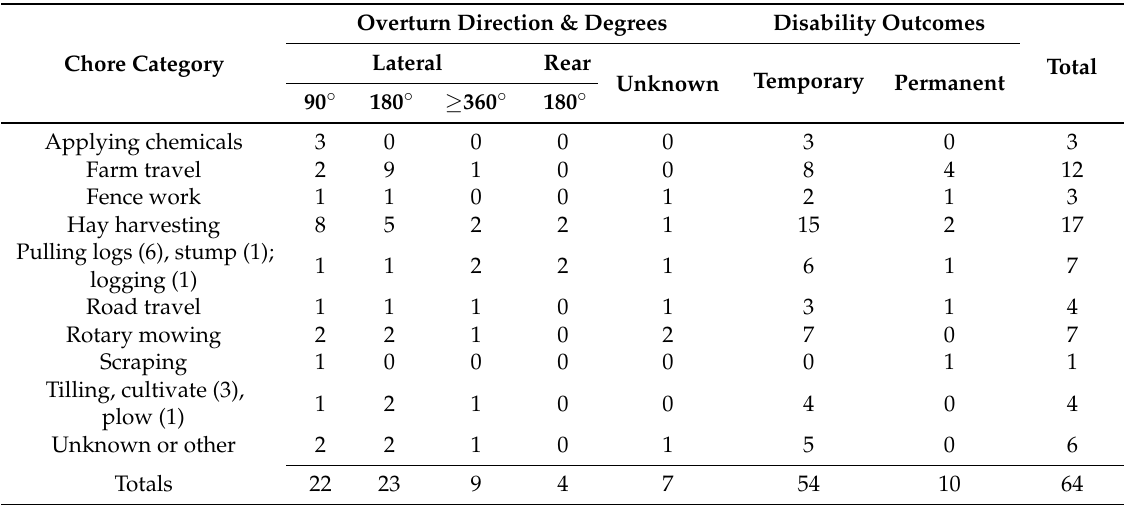
Table 5. Chore category and selected variables for overturns of non-ROPS nonfatal injuries, n = 64.